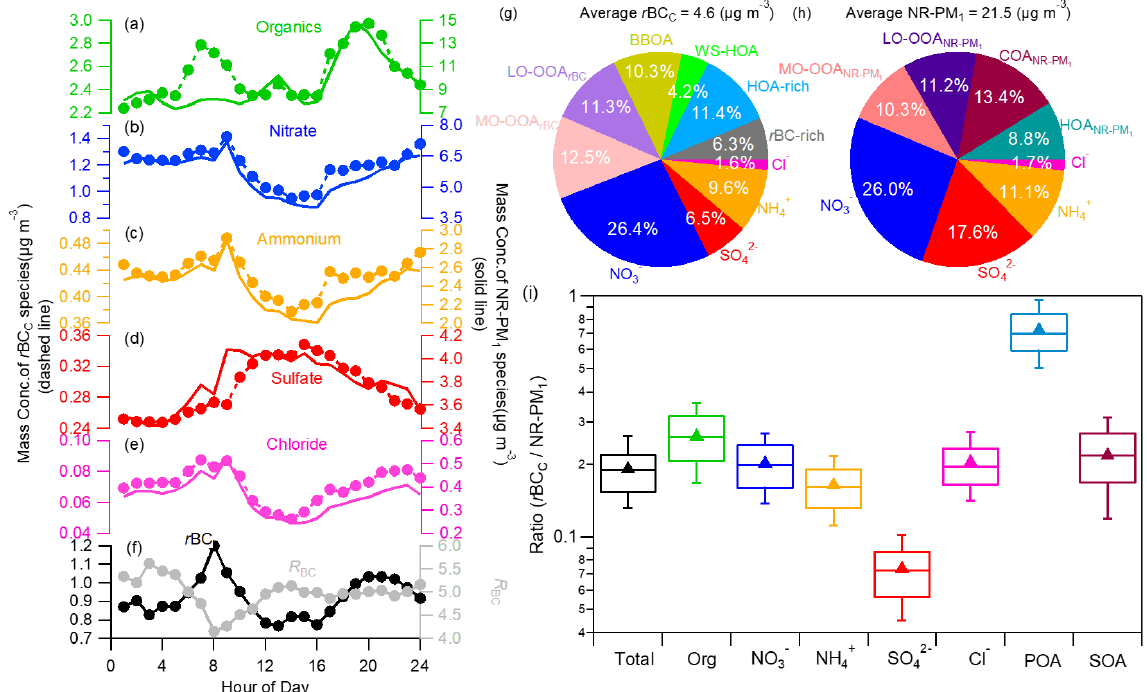
Figure 2. Diurnal cycles of the mass concentrations of (a–e) rBCc-particle and NR-PM 1 species (organics, nitrate, ammonium, sulfate and chloride) and (f) rBC and R BC . The campaign-average chemical compositions of rBCc particles (g) and NR-PM 1 (h) are also shown. (i) Mass ratios of species in rBCc particles with respect to those species in NR-PM 1 (the whiskers above and below the boxes mark the 90% and 10% percentiles, respectively; the upper and lower edges of the boxes represent the 75% and 25% percentiles, respectively; and the lines and triangles inside the boxes denote the median and mean values, respectively; SOA represents ([LO-OOA rBC ] + [MO-OOA rBC ]) / ([LO- OOA NR-PM ] + [LV-OOA NR-PM ]) and POA represents ([rBC-rich + HOA-rich + BBOA + WS-HOA]) / HOA NR-PM 1 1